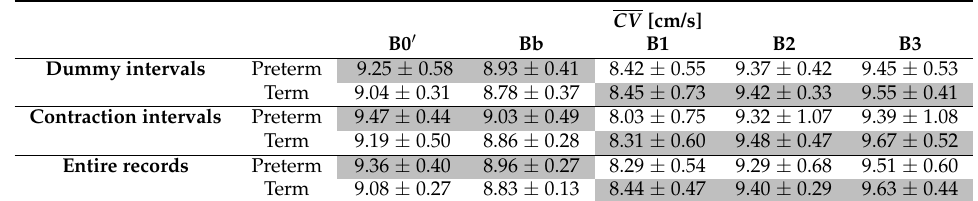
Table 1. Aggregate average conduction velocity amplitudes, CV , for dummy and contraction intervals, and for entire EHG records. The highest velocity amplitudes per frequency band, per type of interval, and per type of records are shaded in